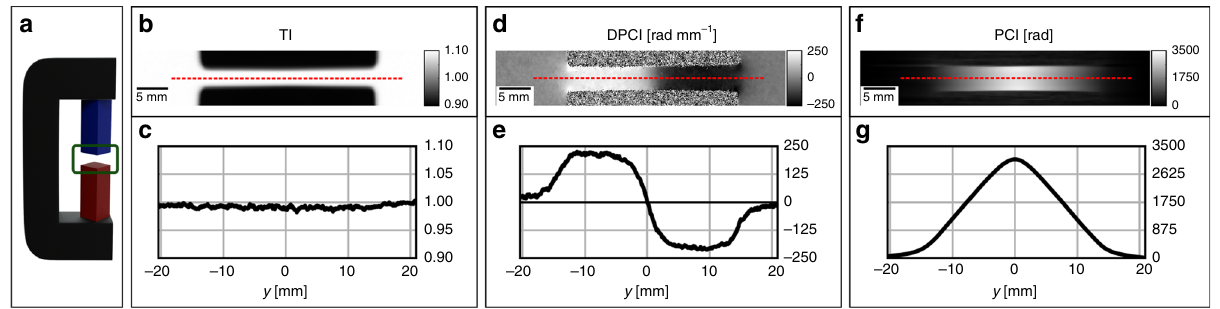
Fig. 3 Transmission image (TI), differential phase contrast image (DPCI), and phase contrast image (PCI) results of a homogeneous and uniaxial magnetic fi eld. a Sketch of the yoke sample and the green box highlights of the region of interest. b Conventional attenuation image, the two black regions are the neodymium permanent magnets of the pole shoes. c Horizontal line pro fi le of the TI. d DPCI, the strong contrast emerges in between the two pole shoes and sharply drops outside the air gap. e DPCI line pro fi le showing the two-step opposite values due to the constant gradient of the magnetic fi eld distribution. f Integrated PCI. g PCI line pro fi le showing the triangular shape characteristic of a constant gradient. The images refers to a single spin state orientation